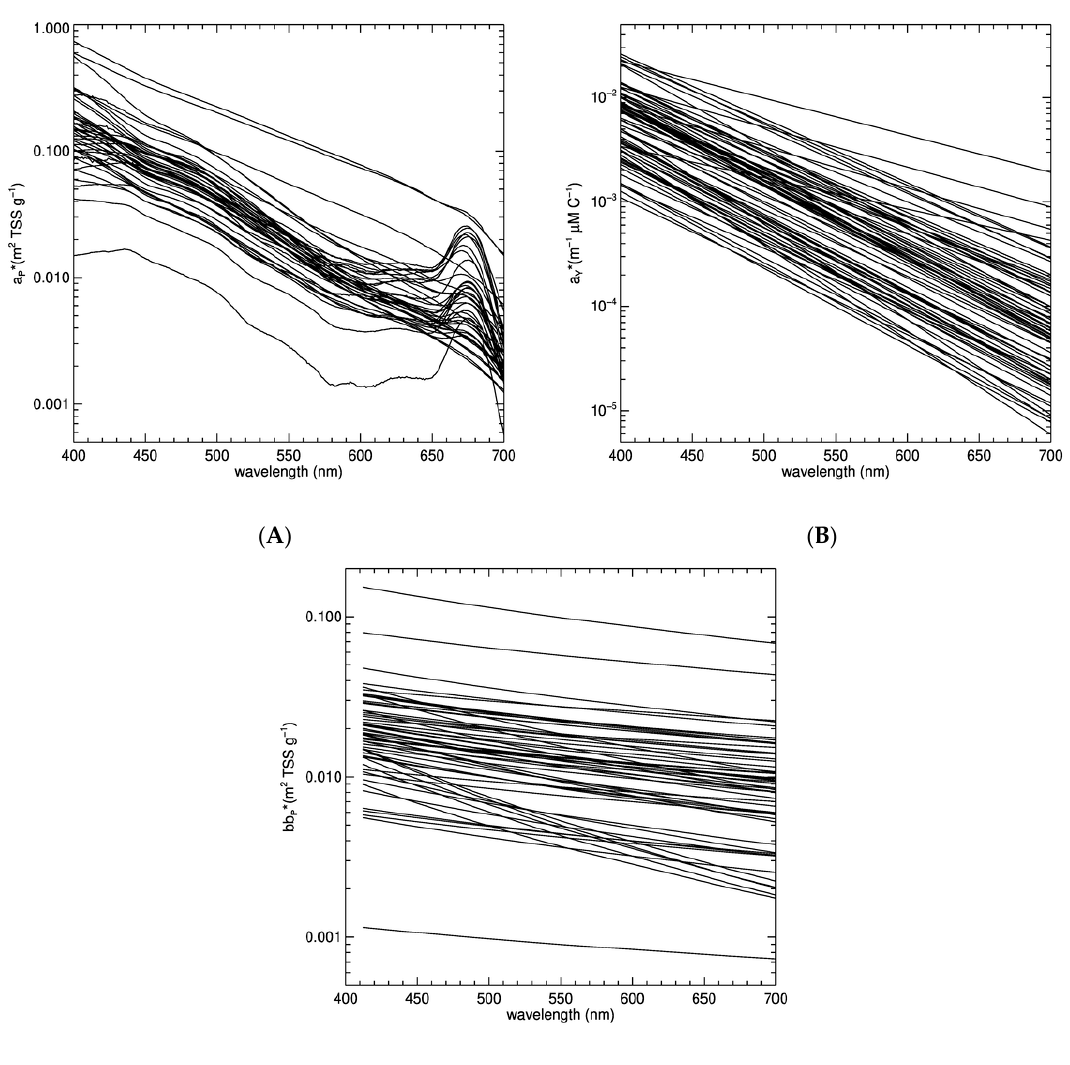
Figure 3. Specific inherent optical properties included in the Sarawak spectral optical library. ( A ) TSS-specific particulate absorption, ( B ) DOC-specific absorption due to CDOM and ( C ) TSS-specific particulate backscattering.